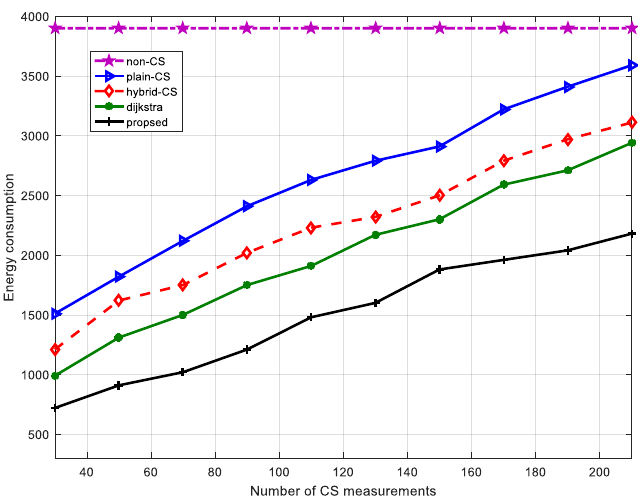
Figure 15. Energy consumption comparison of different data-gathering schemes with a change in the number of CS measurements.